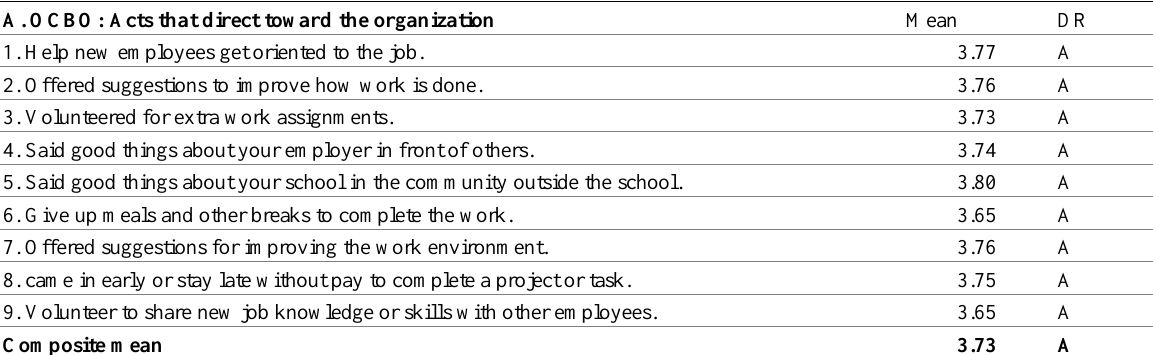
Table 1: The Organizational Citizenship Behavior of Employees as to